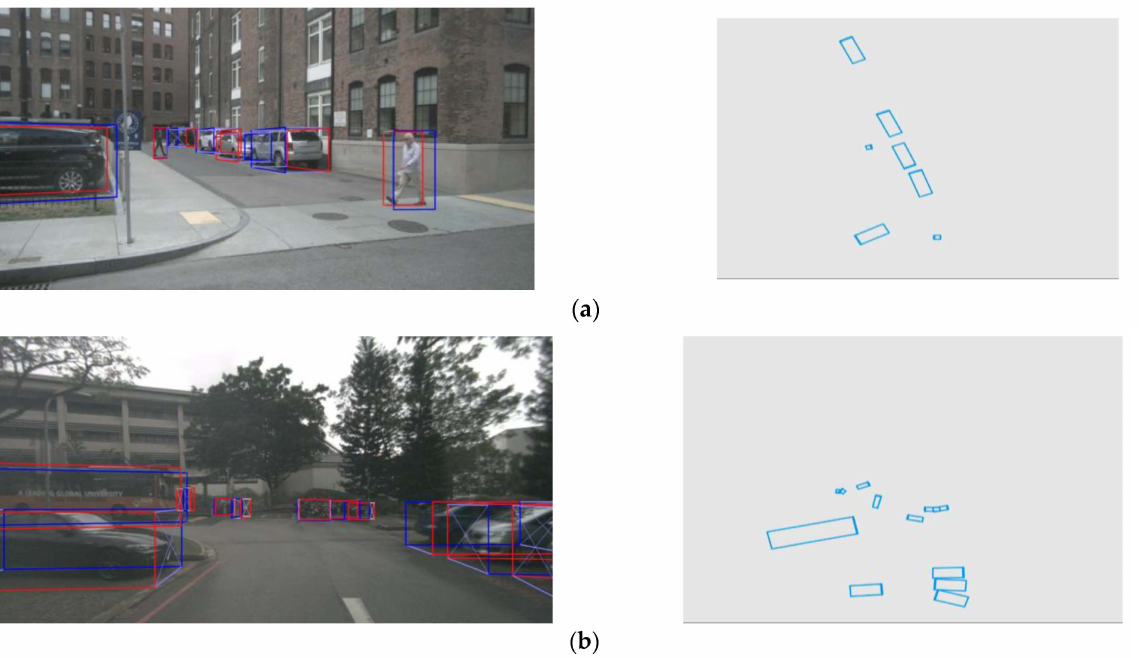
Figure 14. Detection results of targets in general scenes: ( a ) multi objective situation; ( b ) multi scale target